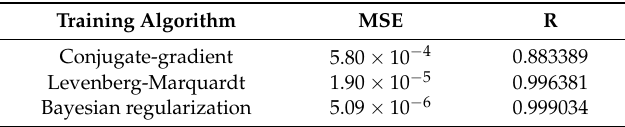
Table 2. Testing training algorithms with testing data.